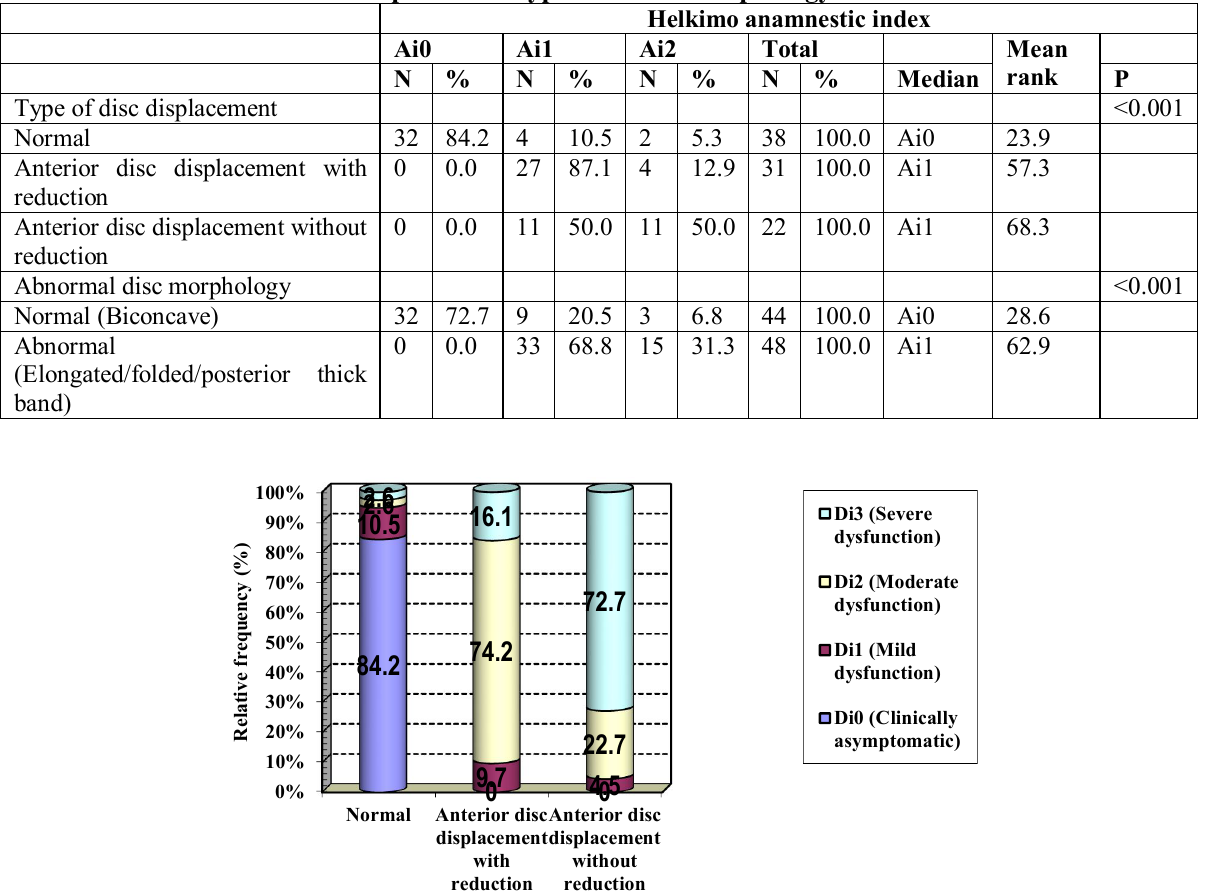
Figure 1: Correlation between Helkimo clinical dysfunction index and MRI findings of type of disc displacement.